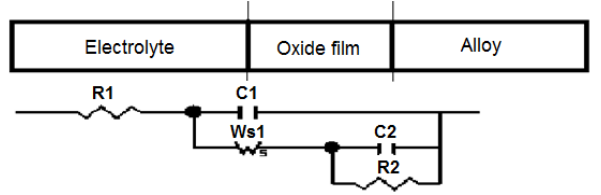
Figure 9. Equivalent circuit for the heat-treated alloy with 0.06% boron.